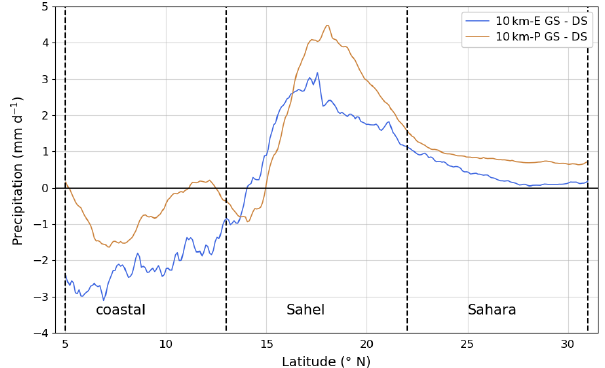
Figure B6. Difference of the JAS mean meridional precipitation distribution between the GS and DS simulation for the 10km-E simulations (blue line) and the 10km-P simulation (orange line), respectively. The vertical black dashed lines indicate the borders of the coastal, the Sahel, and the Sahara region outlined in Fig.